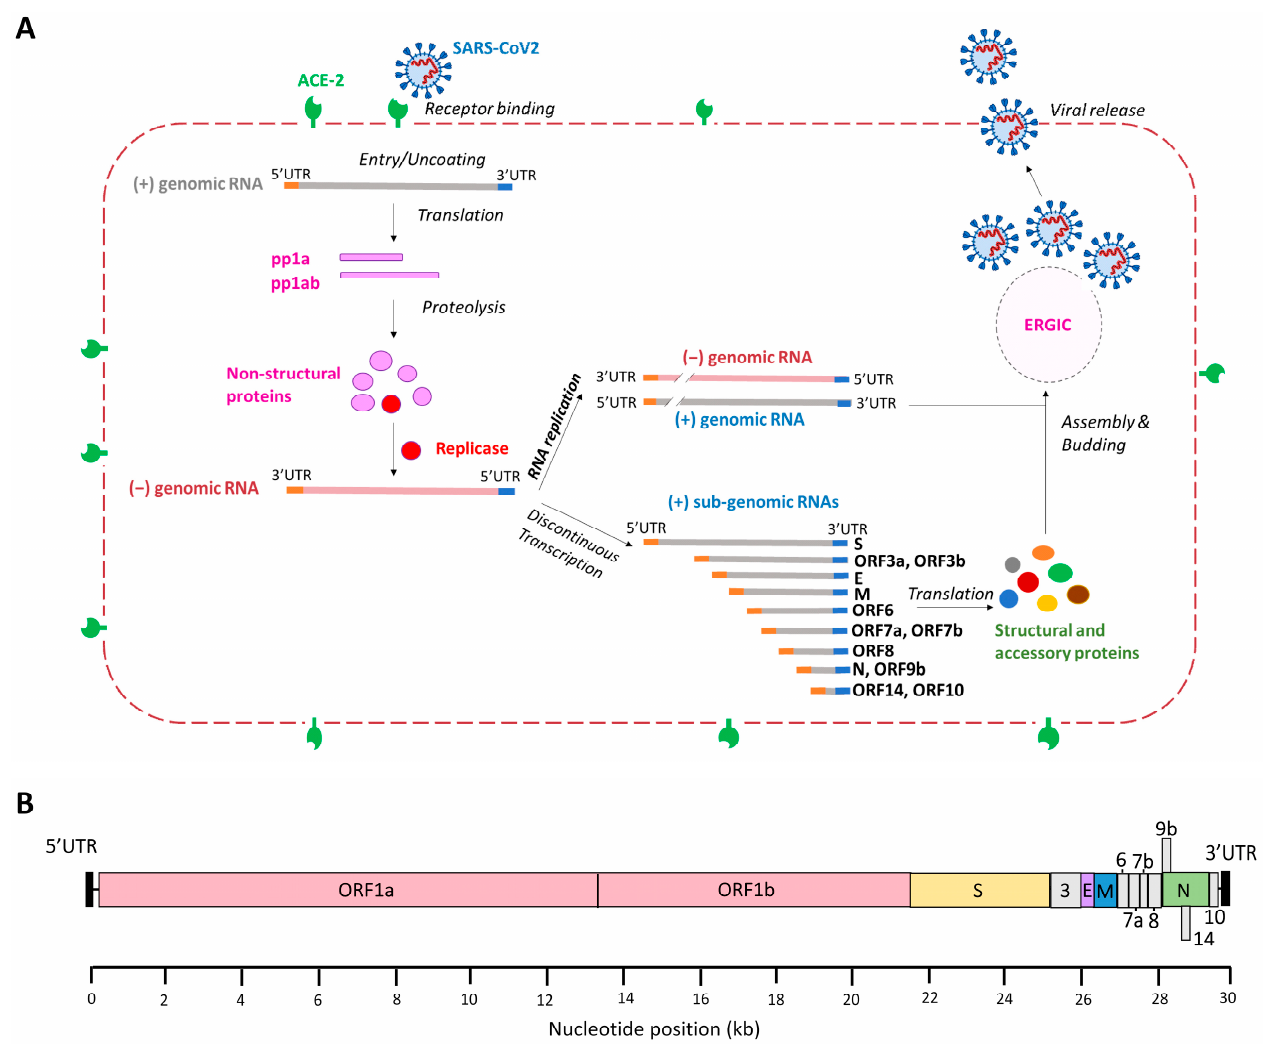
Figure 1. Replication cycle of SARS-CoV-2 and genome organization. ( A ) The SARS-CoV-2 replication cycle. Binding of the viral S protein to the ACE-2 receptor triggers SARS-CoV-2 infection and the plus genomic RNA (+gRNA) is translated into polyprotein (pp)1a and pp1ab. These proteins are proteolytically cleaved to generate 16 non-structural proteins (nsps), including some that form the replication/transcription complex that drives the synthesis of minus genomic RNA ( − gRNA). The − gRNA is converted into genomic +gRNA that is packaged into new virion particles. Discontinuous transcription generates a set of 3 (cid:48) co-terminal sub-genomic mRNAs (sgmRNAs) with identical 5 (cid:48) - leader and 3 (cid:48) -trailer ends. The sgmRNAs are translated into structural and accessory proteins that are required for the assembly of infectious virions, which takes place at the ER-Golgi intermediate compartment (ERGIC). Nascent virions are released from the cell via exocytosis. ( B ) The SARS-CoV-2 RNA genome. Human coronaviruses contain the largest viral genome (27–31 kb) among the RNA viruses and they share a similar genome organization. At the 5 (cid:48) -terminus two large overlapping open reading frames (ORFs), ORF 1a and ORF 1b, encode non-structural proteins and the 3 (cid:48) -terminal ORFs encode four structural proteins: spike (S), envelope (E), membrane (M) and nucleocapsid (N). The SARS-CoV-2 genome encodes eight accessory proteins: 3, 6, 7a, 7b, 8, 9, 14 and 10. Accessory proteins are indicated in